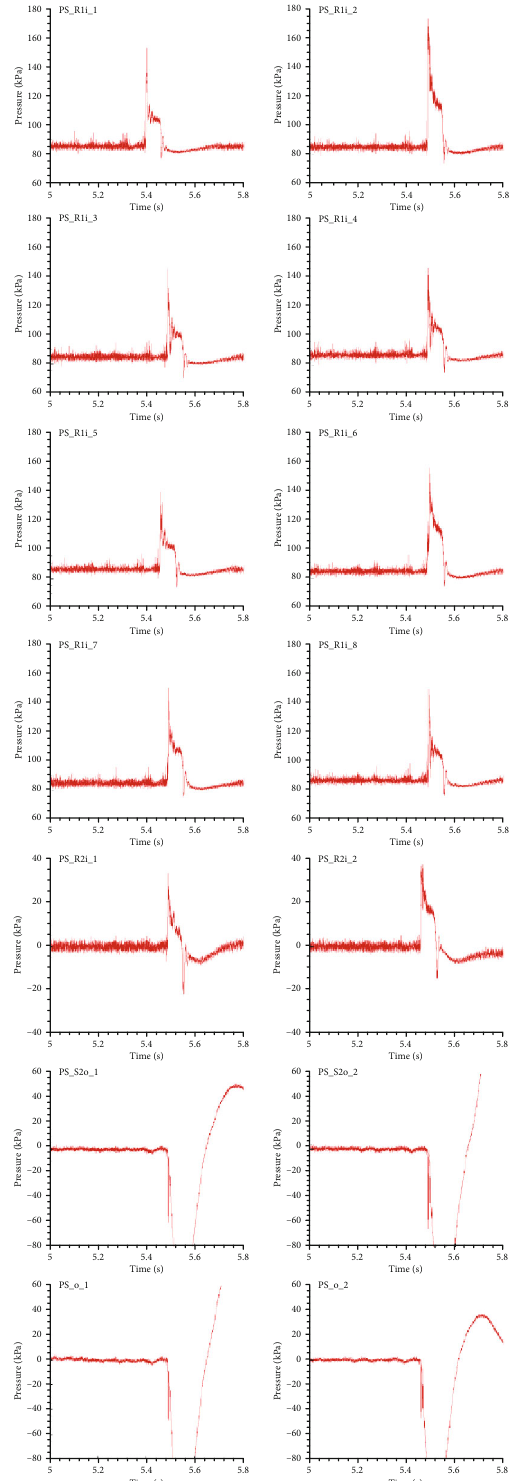
Figure 14: Static pressure changes at di ff erent positions in the dynamic instability process of the